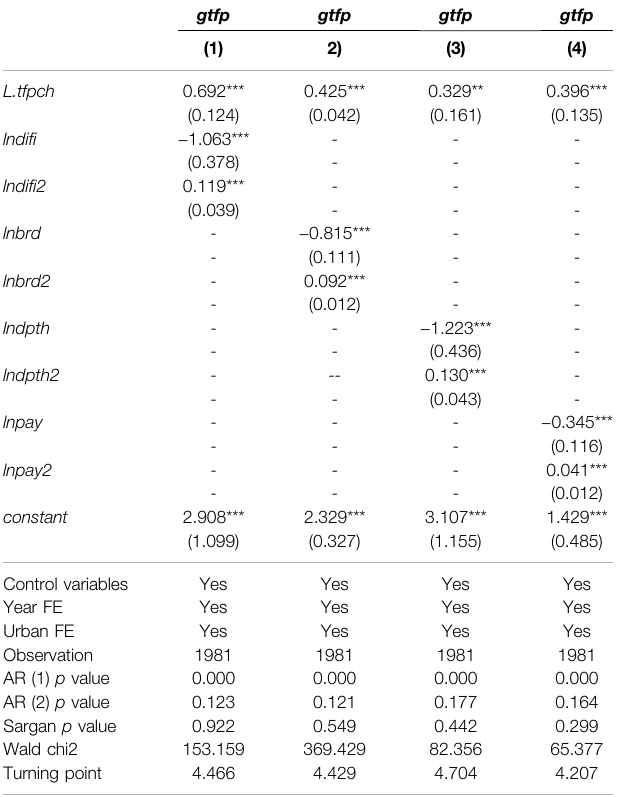
TABLE 6 | The stimation of